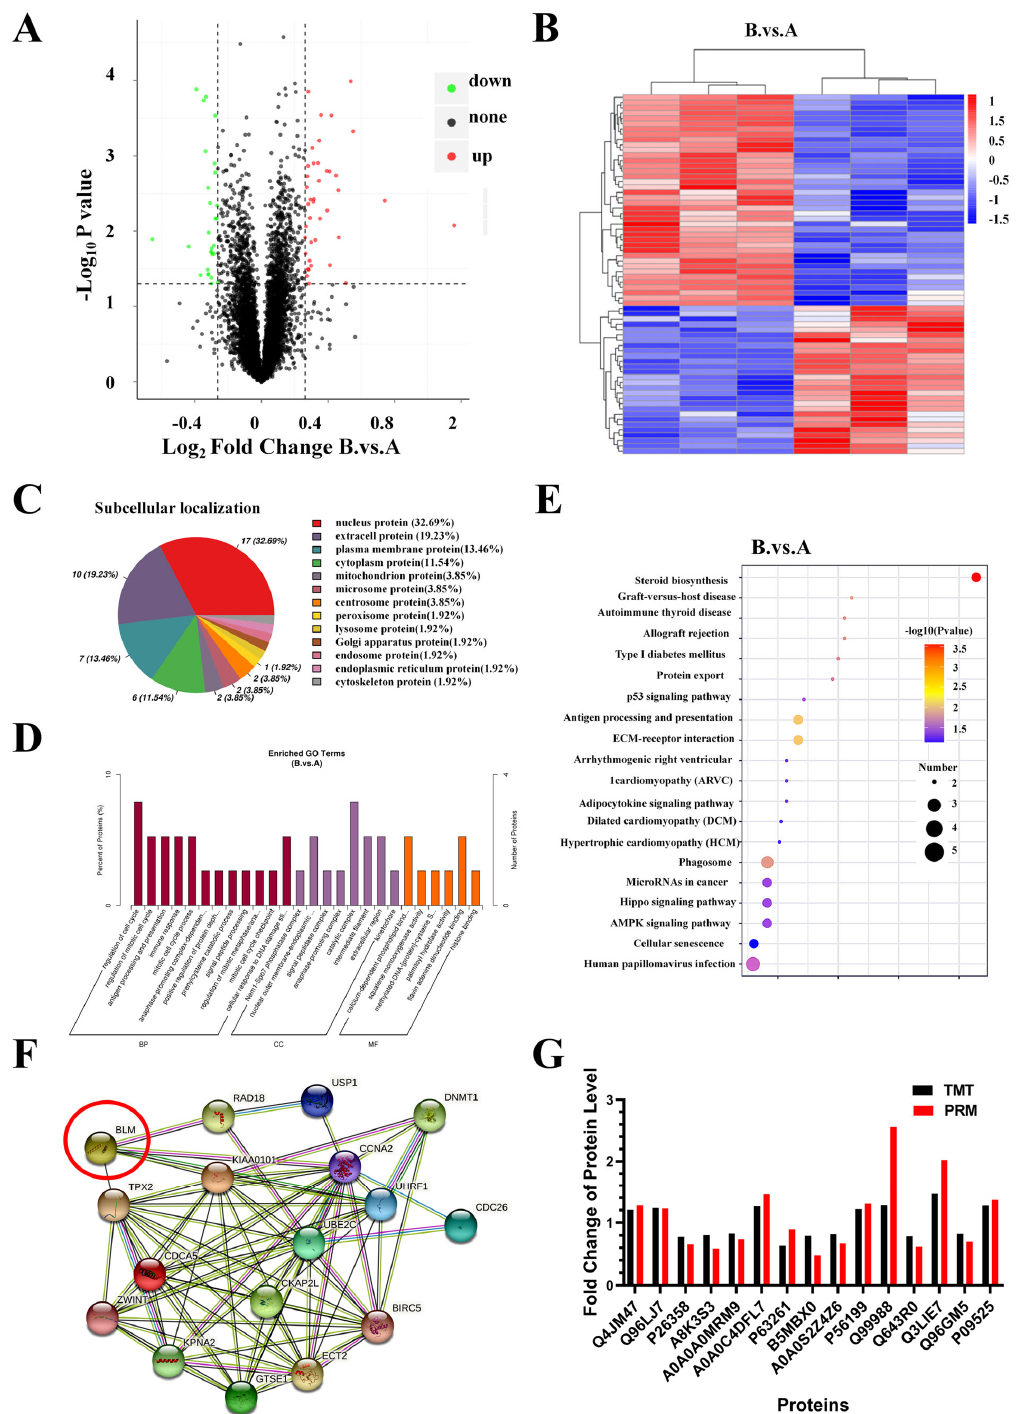
Figure 8. Identification and bioinformatics analysis of differently expressed proteins (DEPs) in PC3 cells after AO/854 treatment. ( A ) Volcanic map of DEPs in PC3 cells after AO/854 (5 µ mol/L) treat- ment. ( B ) Cluster heat map of DEPs in PC3 cells after AO/854 (5 µ mol/L) treatment. ( C ) Subcellular localization analysis of DEPs in PC3 cells after AO/854 (5 µ mol/L) treatment. ( D ) Gene ontology (GO) analysis of DEPs in PC3 cells after AO/854 (5 µ mol/L) treatment. ( E ) KEGG analysis of DEPs in PC3 cells after AO/854 (5 µ mol/L) treatment. ( F ) Protein–protein interaction networks for DEPs and BLM. ( G ) Confirmation of 15 selected differently produced proteins detected by PRM technique. Note: Group A is the negative control group; Group B is the AO/854 treatment group (5 µ